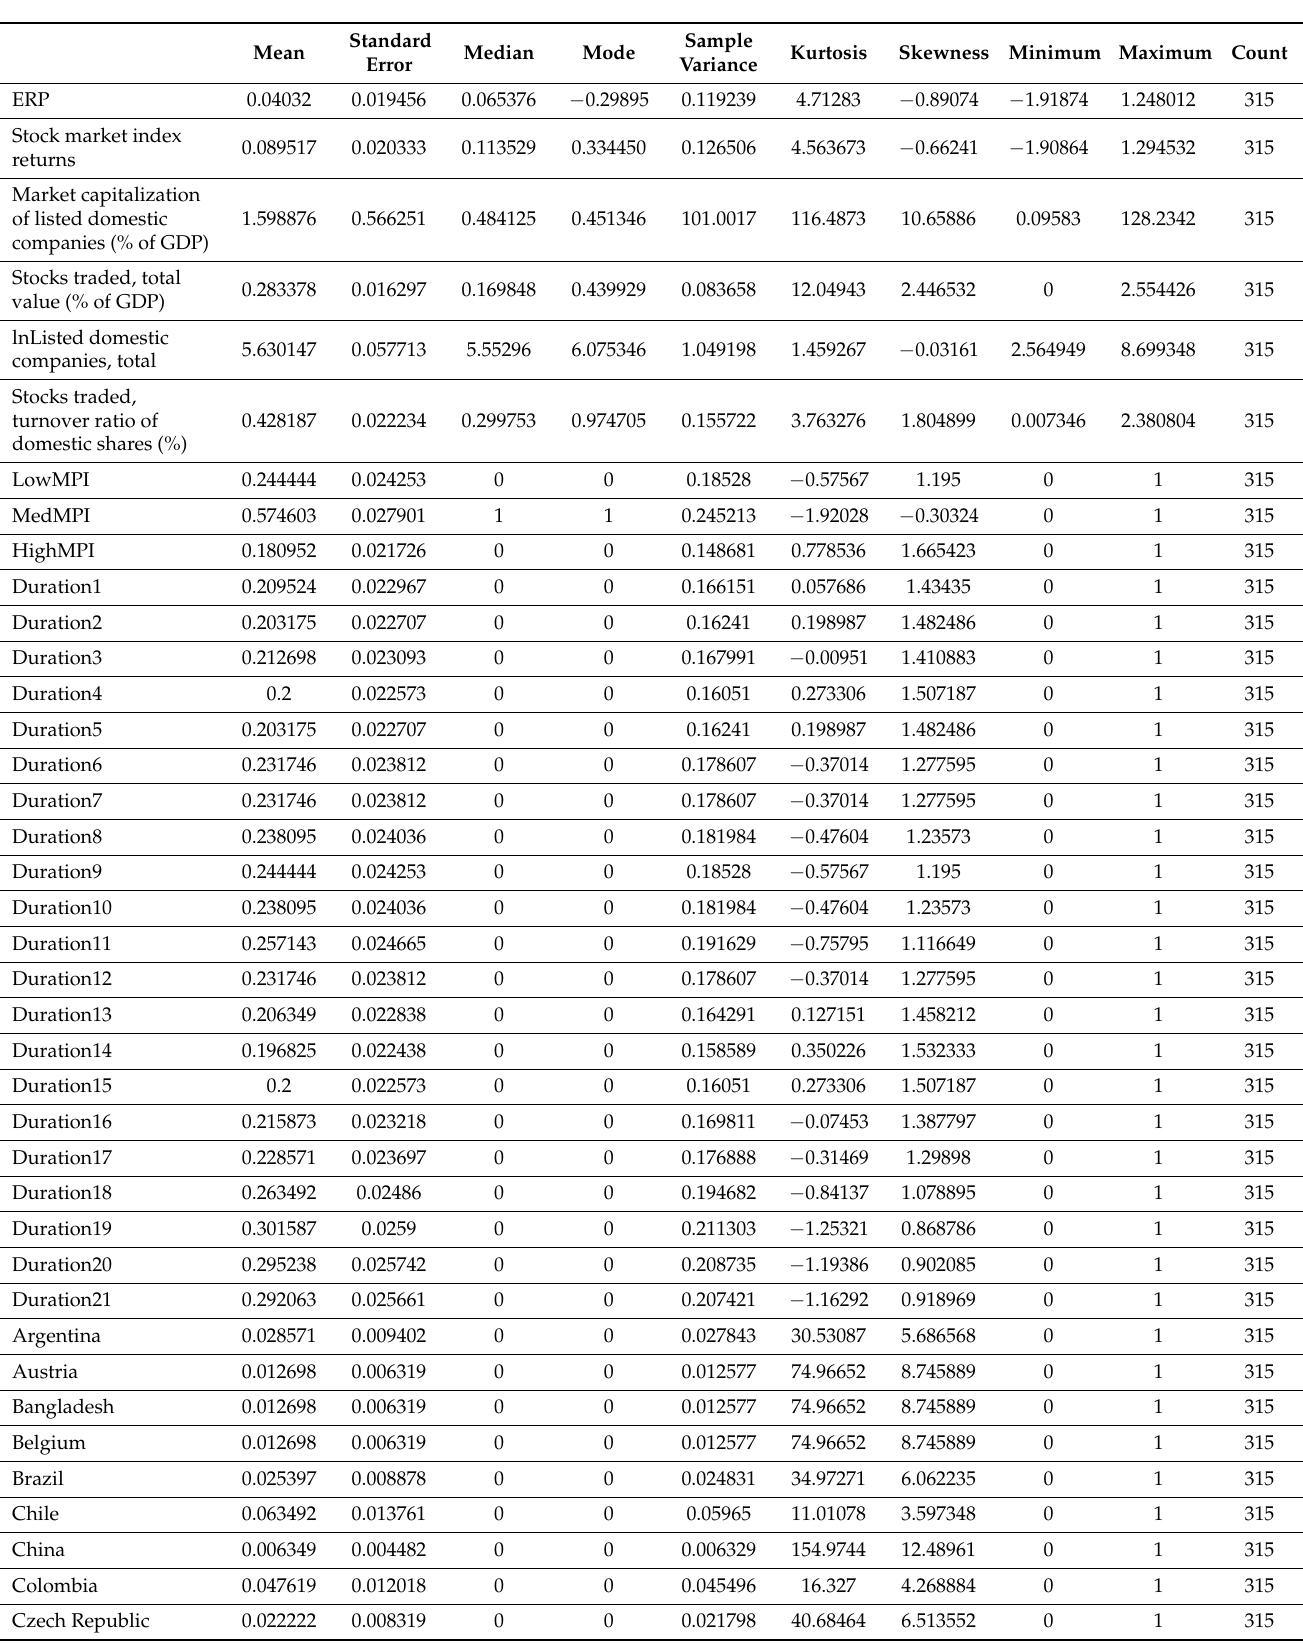
Table A3. Descriptive statistics for the medium level of stock market